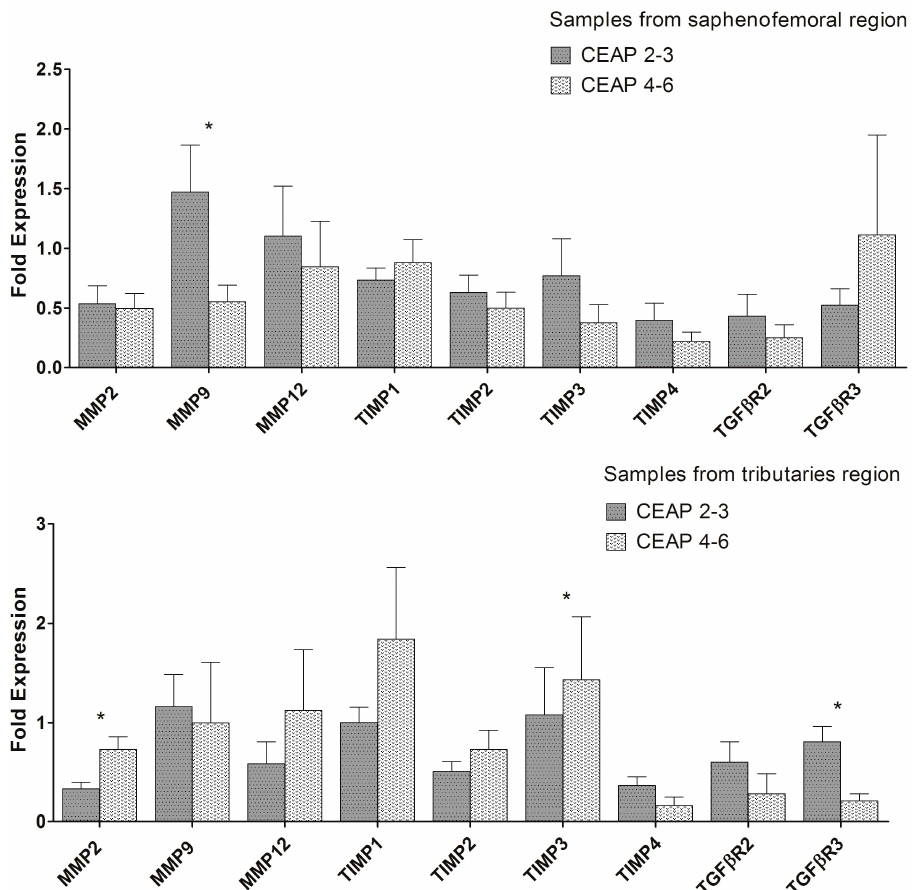
Figure 3. MMP, TIMP, and TGF β R gene expression in the CEAP2–3 and CEAP4–6 veins (from three different regions). Their gene expression was determined by qPCR after normalization with β -actin housekeeping gene. All results are expressed as fold expression. Error bars indicate mean ± SEM, n (CEAP2–3) = 19 and n (CEAP4–6) 12. * p ≤ 0.05.